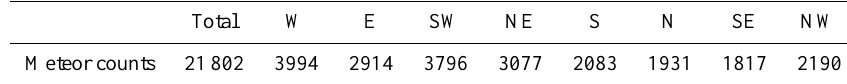
Table 2. Ideal meteor distribution used in our simulation.